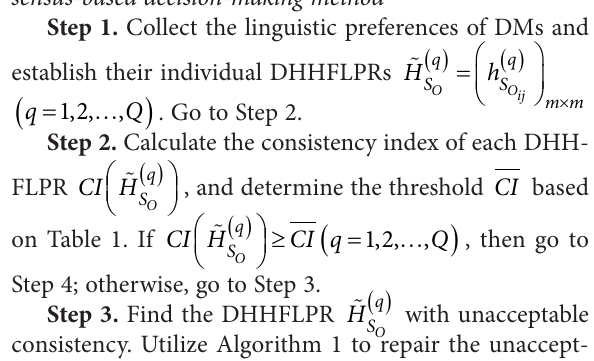
Algorithm 2. The multiplicative consistency and con-